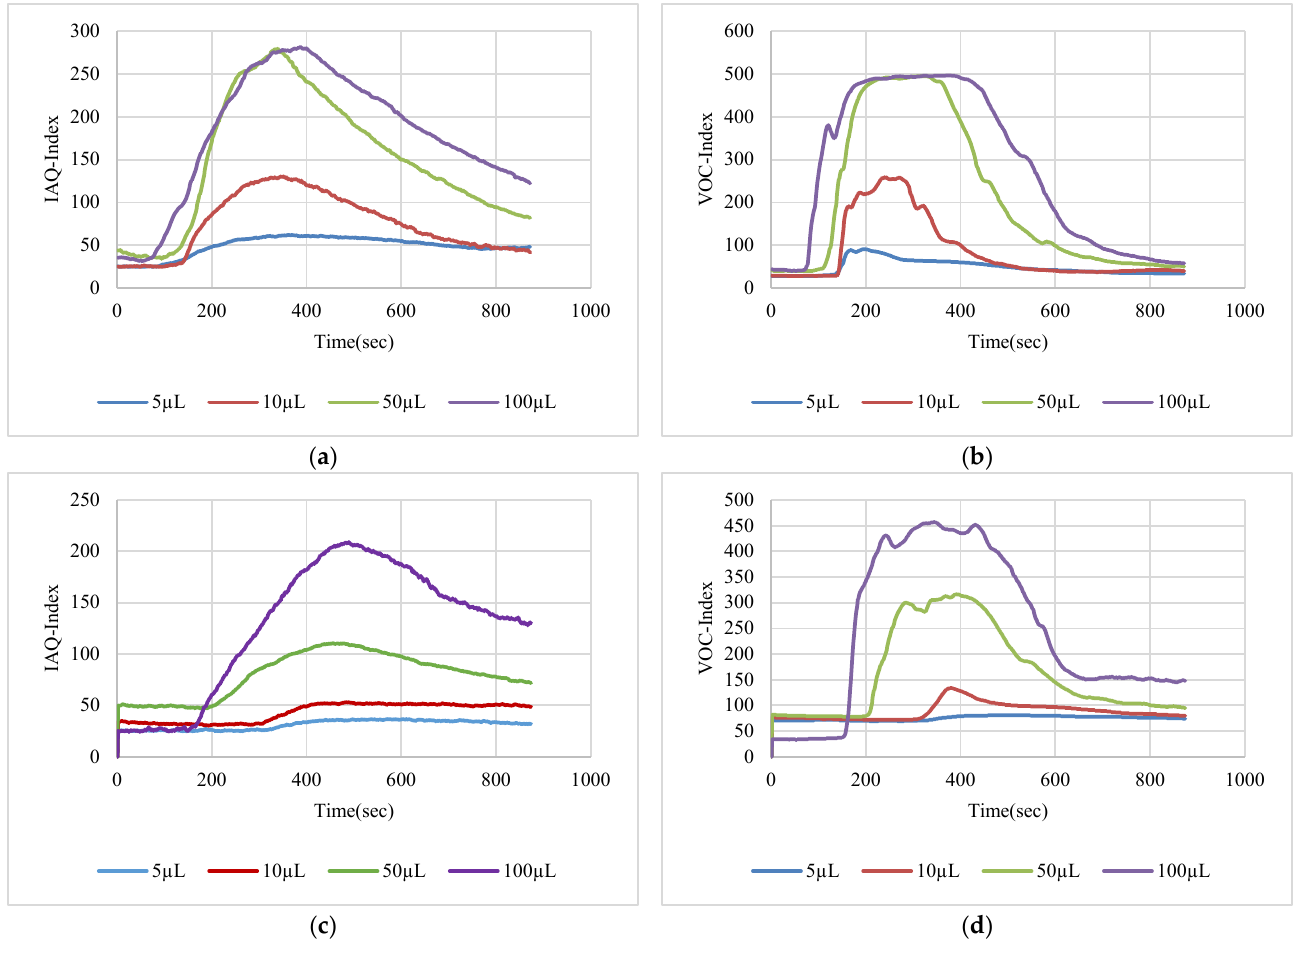
Figure 12. Test results for acetonitrile: ( a ) BME688 40 cm, ( b ) SGP41 40 cm, ( c ) BME688 100 cm, ( d ) SGP41 100 cm.